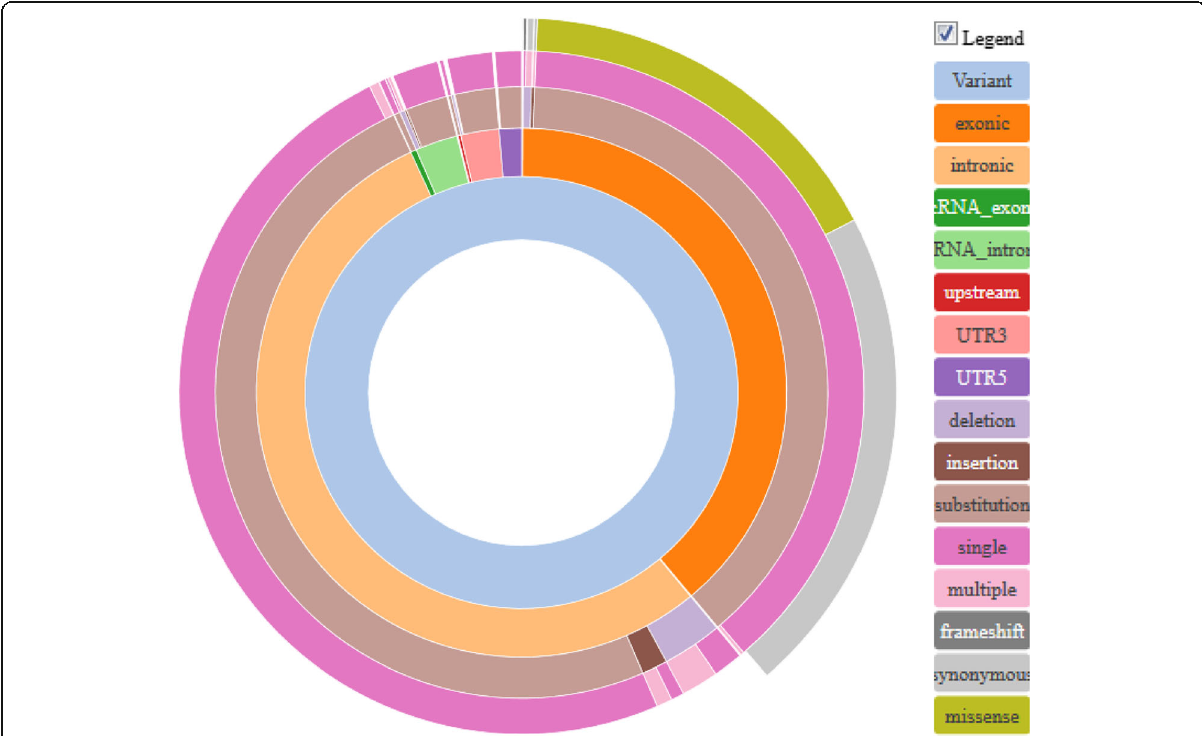
Fig. 1 Sunburst diagram showing the functional classes of 14,655 rare (MAF ≤ 0 .01) sequence variants identified in 33 Black South African and 14 Nigerian PD patients. An interactive HTML-version of the figure is available at BMC